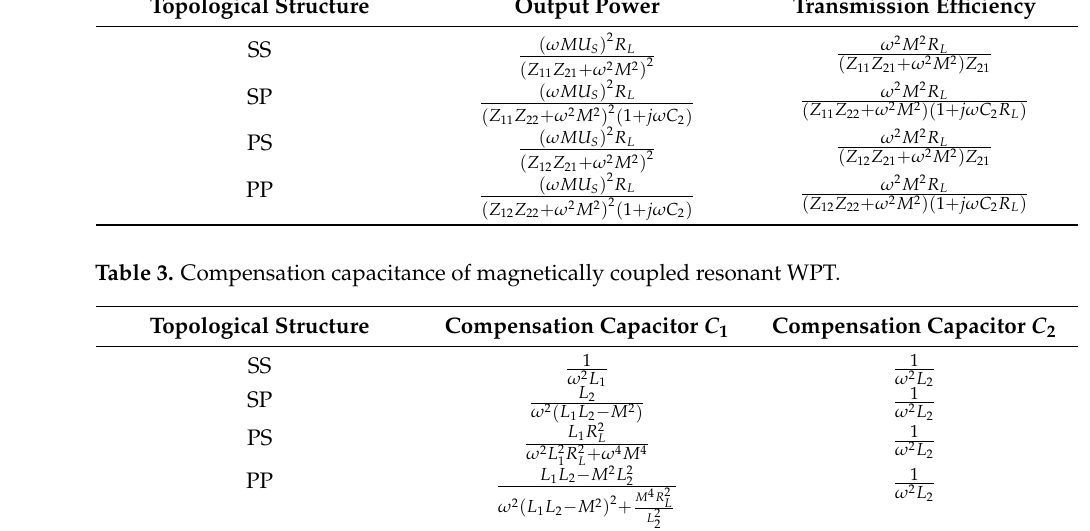
Table 2. Transmission characteristics of magnetically coupled resonant WPT. Topological Structure